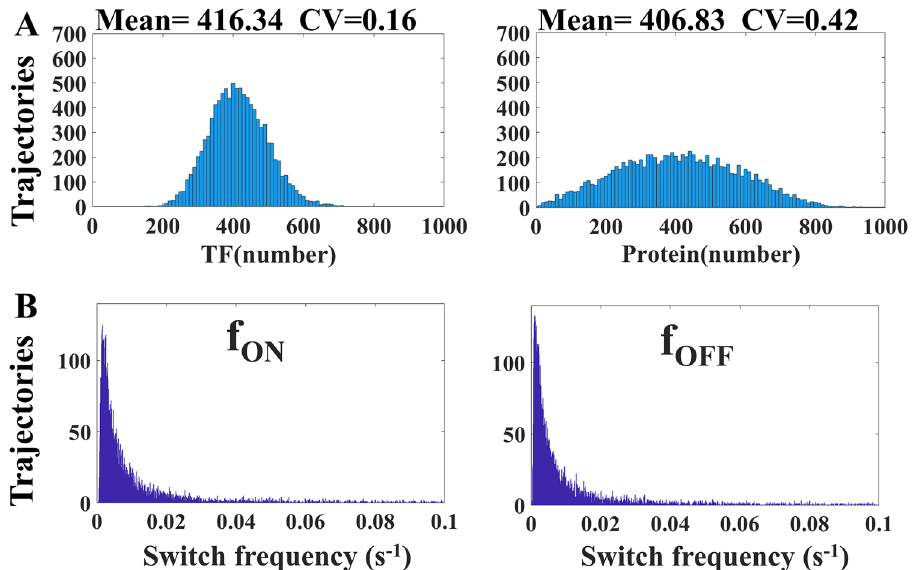
Figure 5. ( A ) shows the distribution of TF B (left panel) and downstream protein (right panel). In comparison to the case in Fig 3A, lower value of TF B leads to higher CV of the downstream protein. ( B ) shows the distribution of switching frequency of